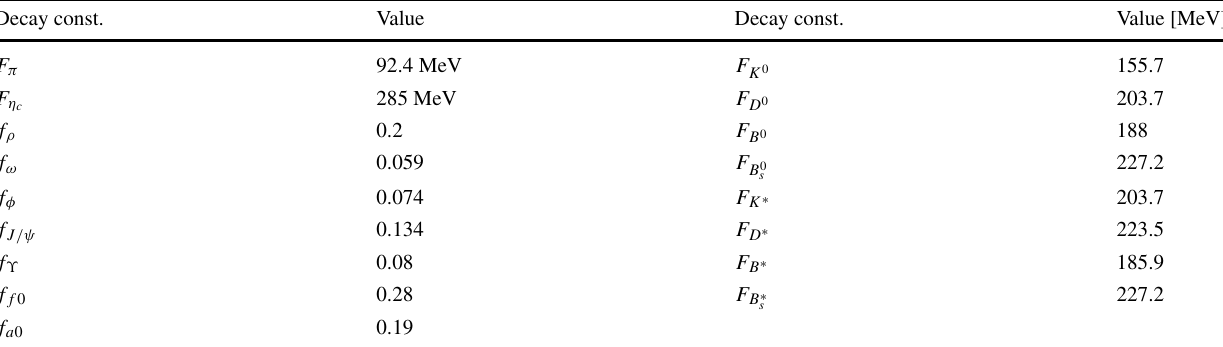
Table 8 The decays constants used in the matching conditions (12)–(14), taken from Refs. [20] and [39]. For the vector meson decay constants, we use experimental values when available, or the values quoted in [39] from the LQCD model Decay const.